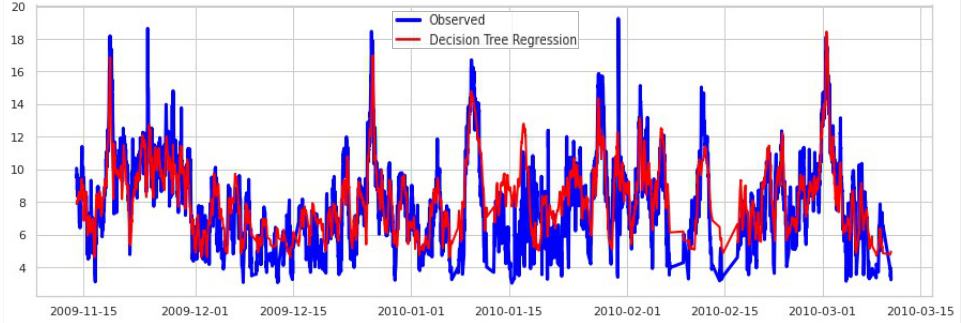
Figure 5. Observed and predicted wind speeds using RF based only in mesoscale data in ms − 1